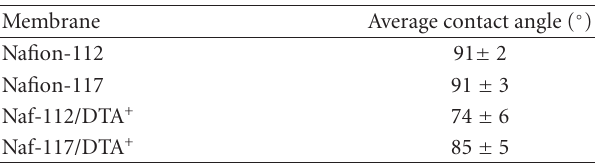
Table 2: Average values of the contact angles for original and IL- modified membranes.